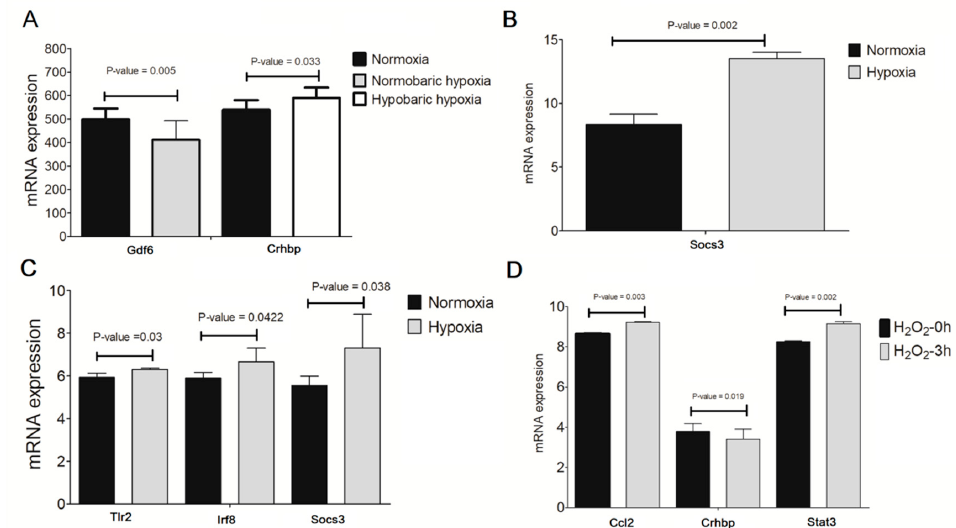
Figure 7. Validation of the expression levels of crucial genes in hypoxia/H 2 O 2 -induced retinal injury models. ( A ) GSE173233 dataset; ( B ) GSE151610 dataset; ( C ) GSE135844 dataset; ( D ) GSE122270 dataset. h, hour.